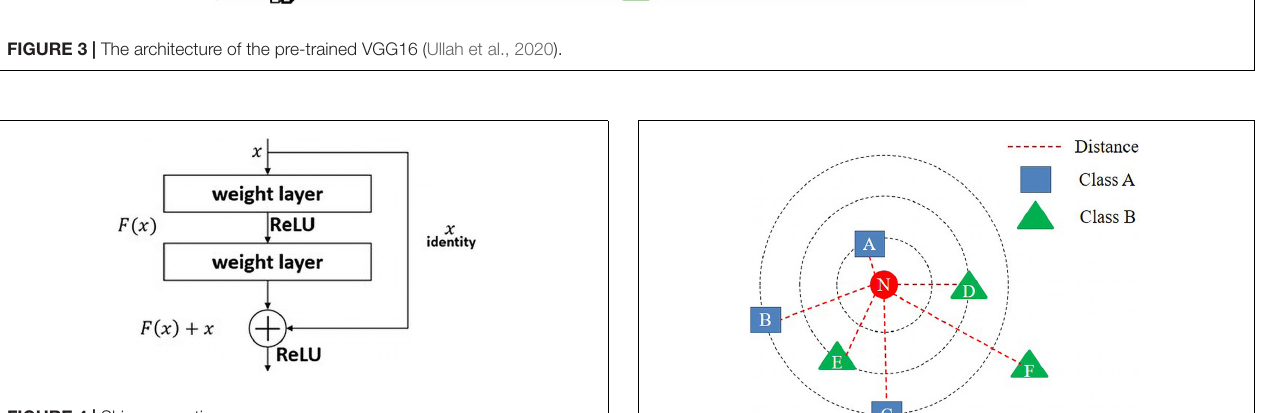
FIGURE 4 | Skip connection.